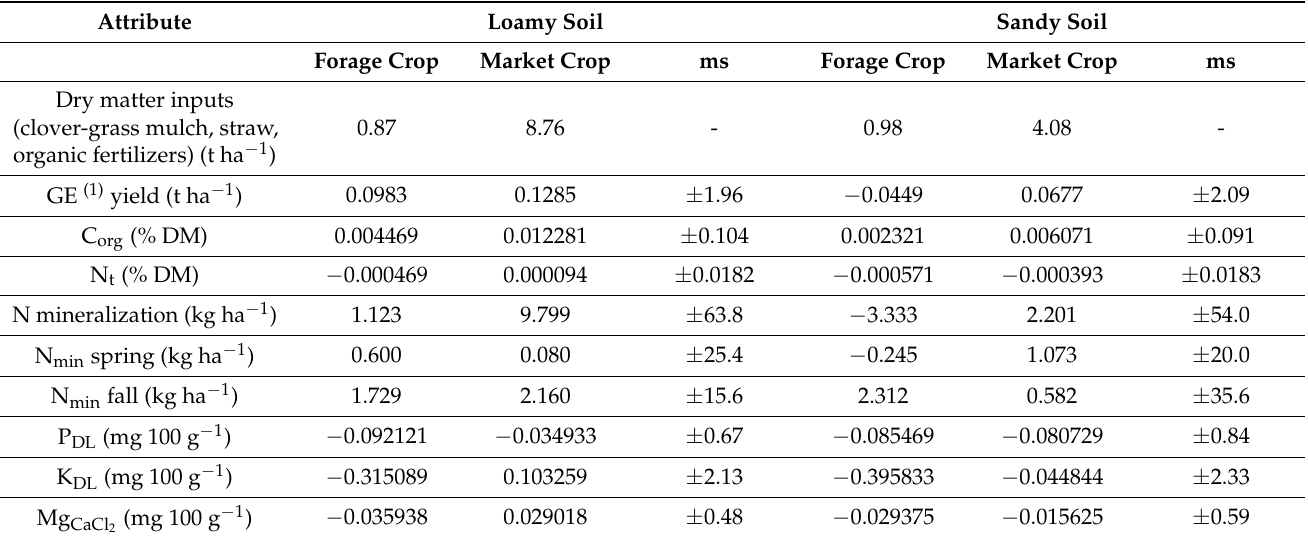
Table 5. Effects of the supply of organic materials in market crop and forage production systems corresponding to an average by 0.5 LU ha − 1 year − 1 on the annual change of certain characteristics from long-term field trials of a loess and sandy soil (accounting period: loess soil = 15 years, sandy soil = 13 years, mean standard error of the regression,